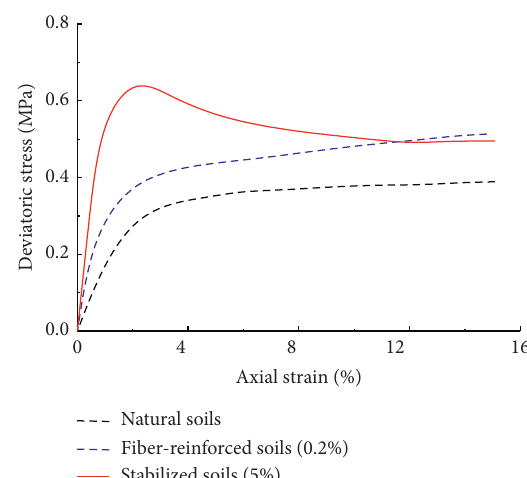
Figure 20: Deviatoric stress for different soils (confining pressure �